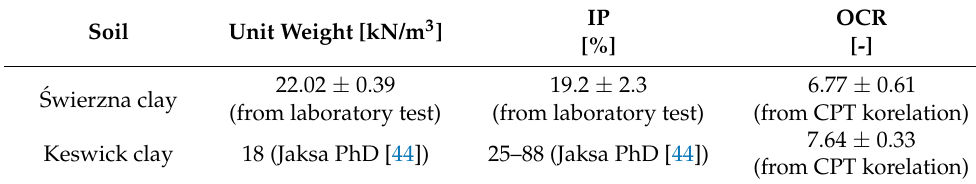
Table 1. Basic characteristics of ´Swierzna and Keswick